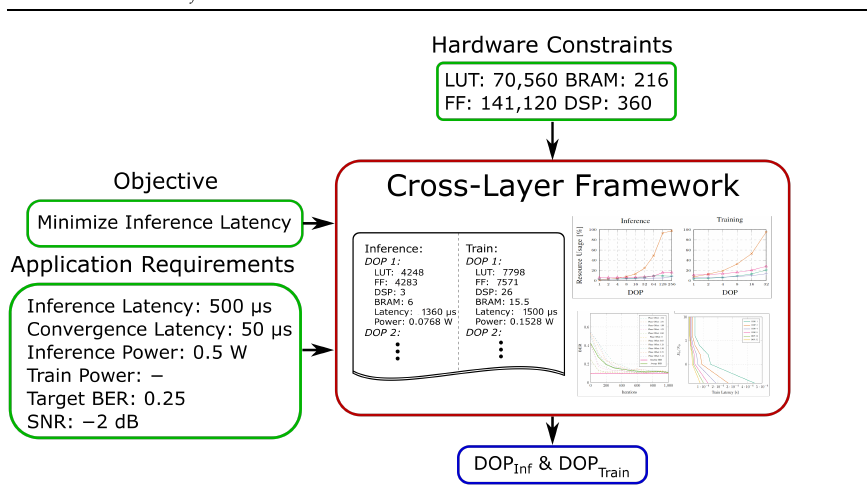
Figure 7. Exploration